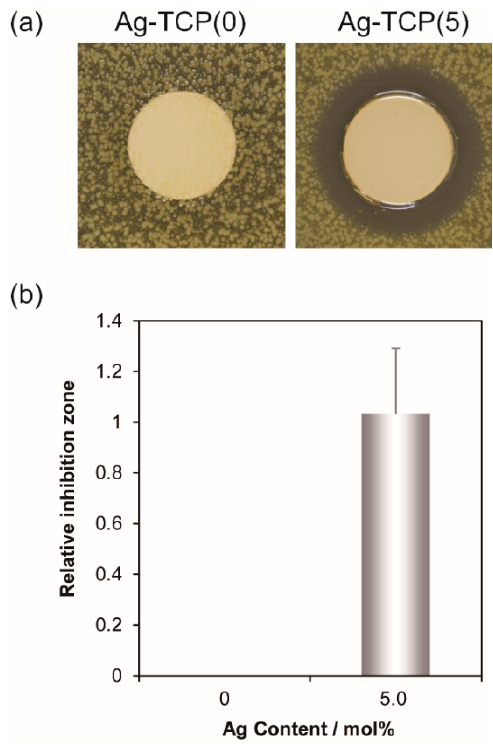
Figure 7. In vitro evaluation of antimicrobial activity by inhibition zone method. Inhibition zone test of Ag-TCP cements: Ag(0) and Ag(5) in S. aureus ( a ). Inhibition zone was calculated by Equation (1) ( b ). Error bars indicate standard error of the mean (n = 3).